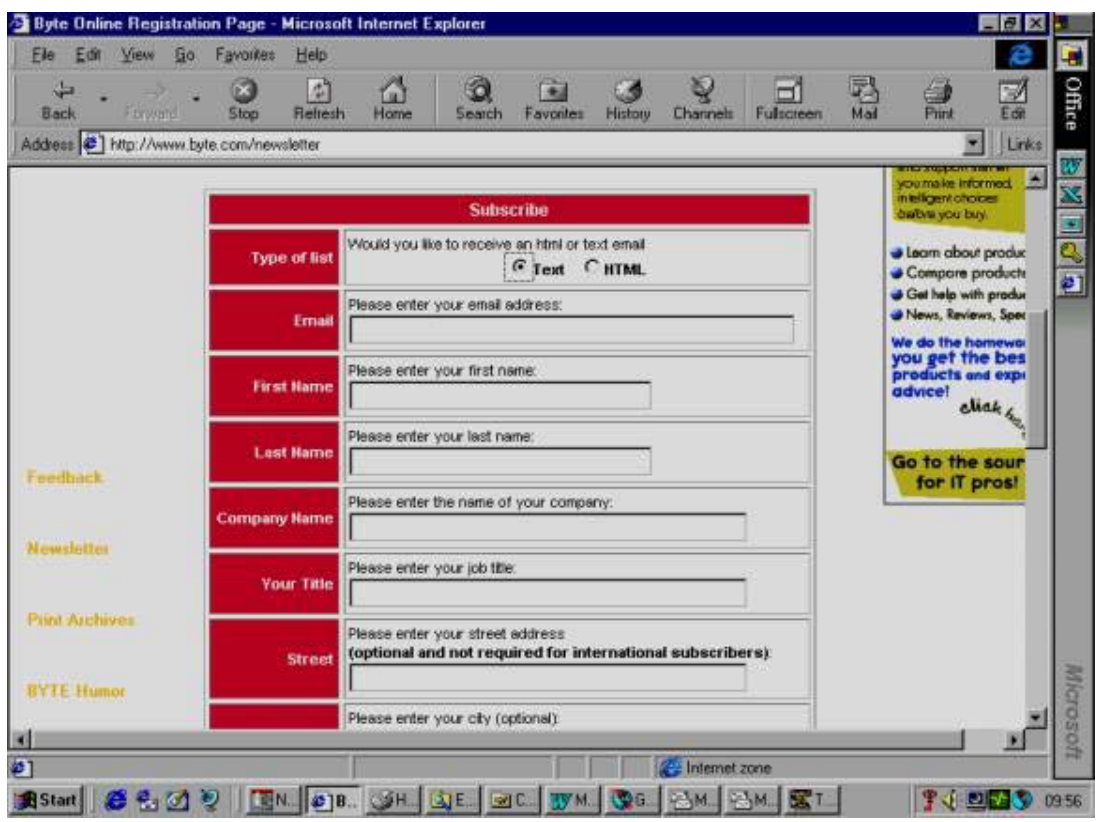
Figure 8 Sign-on screen for source-based